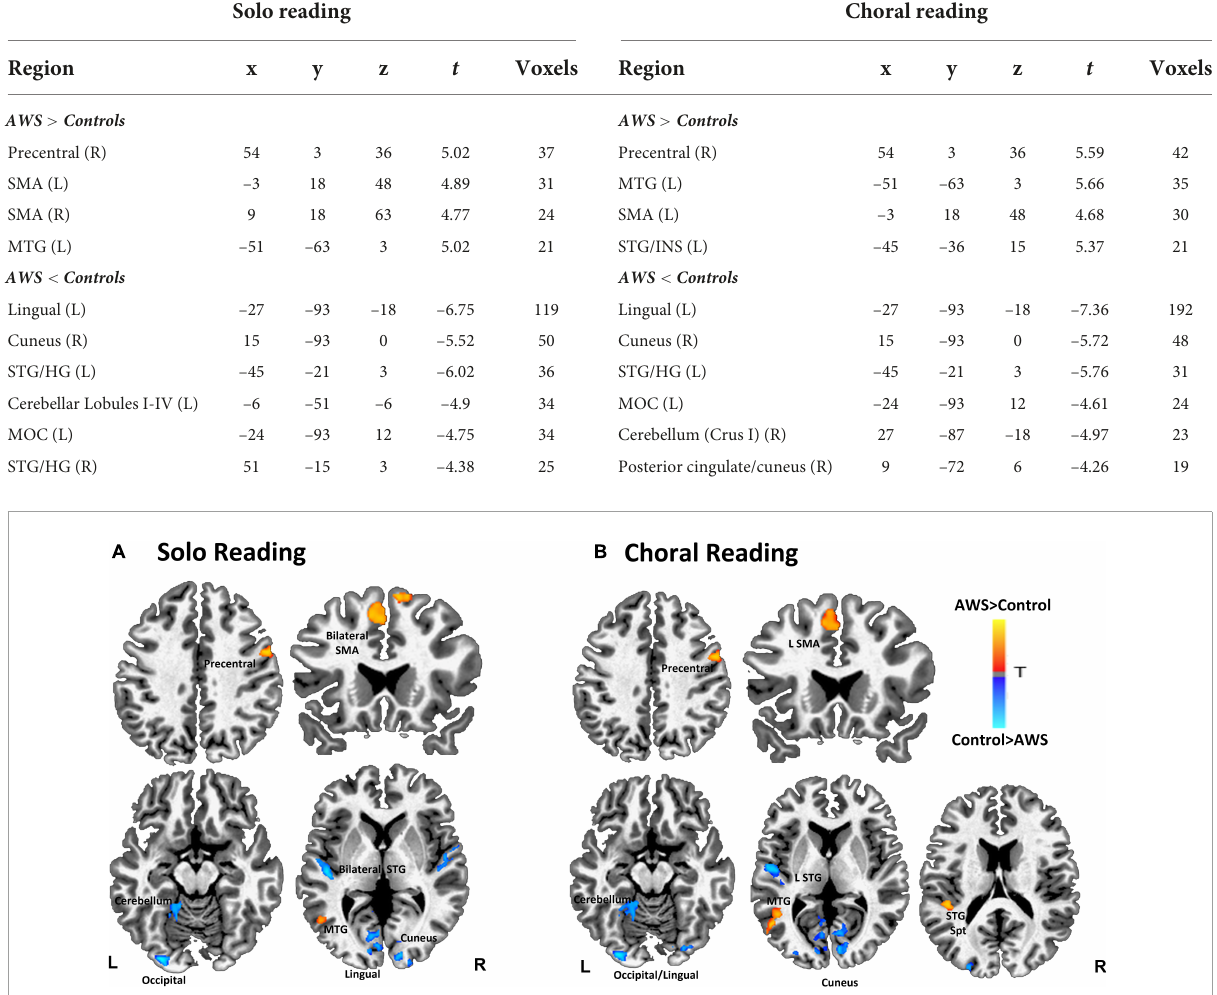
TABLE 1 Group differences in solo reading (left panel) and choral reading (right panel).